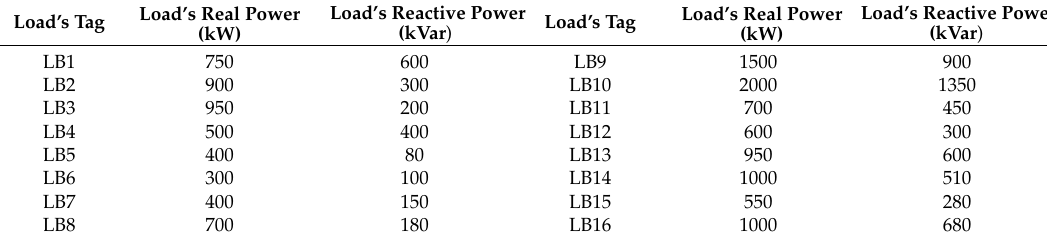
Table 2. 15 kV power system model’s loads.